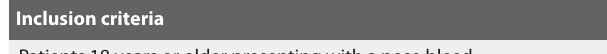
Table 1. Inclusion criteria for pilot study. Inclusion criteria